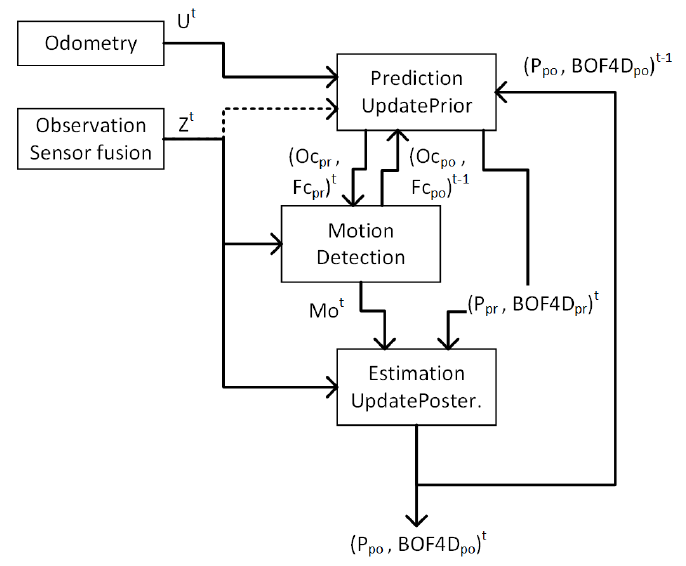
Figure 3. Bayesian Occupancy Framework general